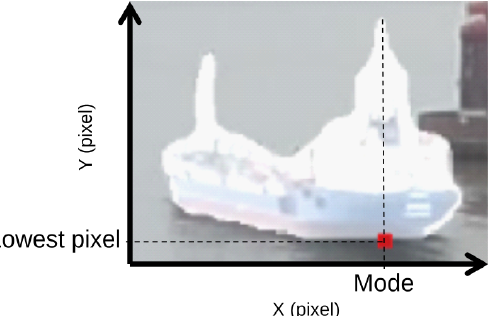
Figure 5. Example of segmented ship mask with calculated pixel to be georeferenced (in red, enlarged for